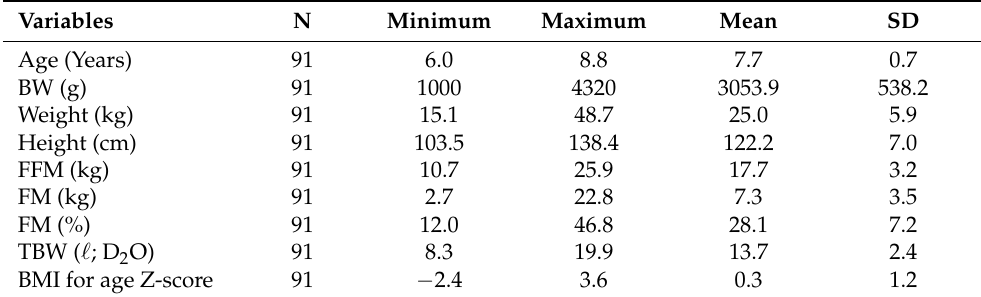
Table 1. Descriptive statistics (minimum, maximum, mean, and SD) and percentages (%) for categori- cal variables of participants.